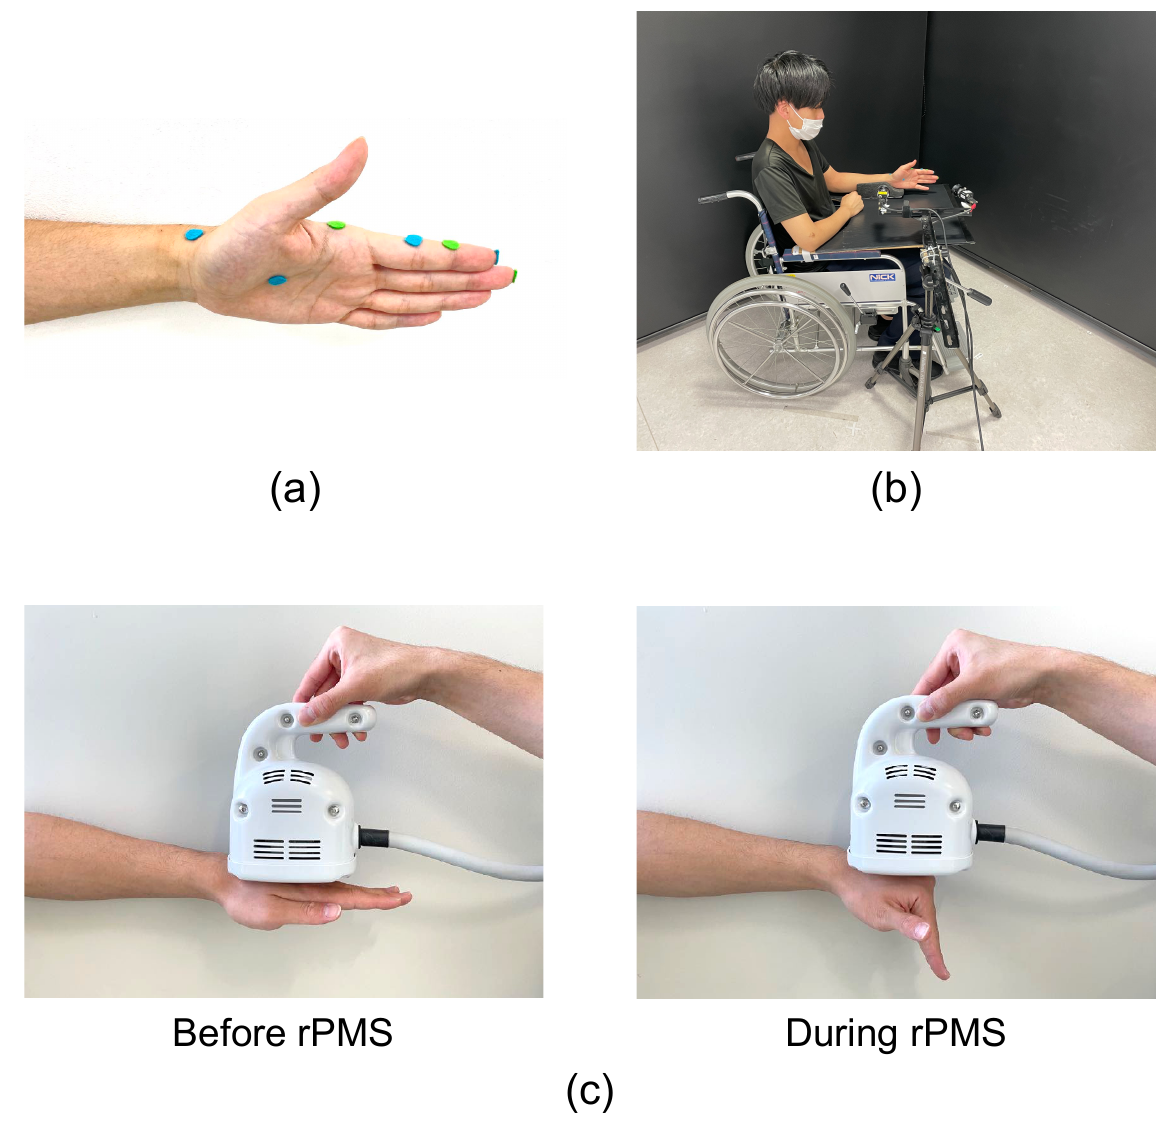
Figure 1. ( a ) Marker placements. Markers were placed at the radial styloid process; the radial side of the MCP, PIP, and DIP joints of the index finger; the tips of the index and middle fingers; and the base of the third metacarpal bone. ( b ) Setting. the participant sat on a chair with their forearm neutral and the MCP, PIP, and DIP joints set at 0 ◦ . ( c ) Stimulation of the intrinsic muscles of the hand from the dorsum using repetitive peripheral magnetic stimulation (rPMS). To stimulate intrinsic muscles, the center of the coil for rPMS was placed between the second and third metacarpal bones on the dorsum of the hand. During rPMS, the MCP joint was flexed while the PIP and DIP joints were